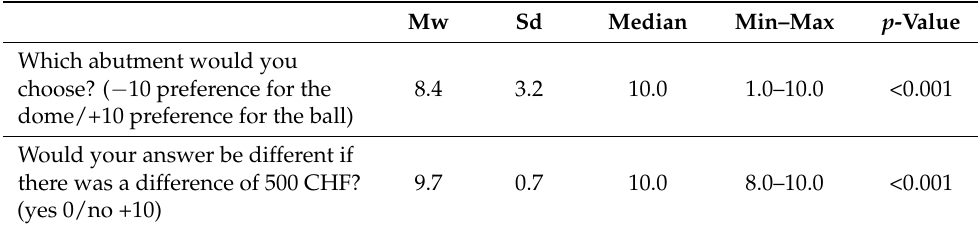
Table 4. Participant ratings at study termination: Numerical rating scales.